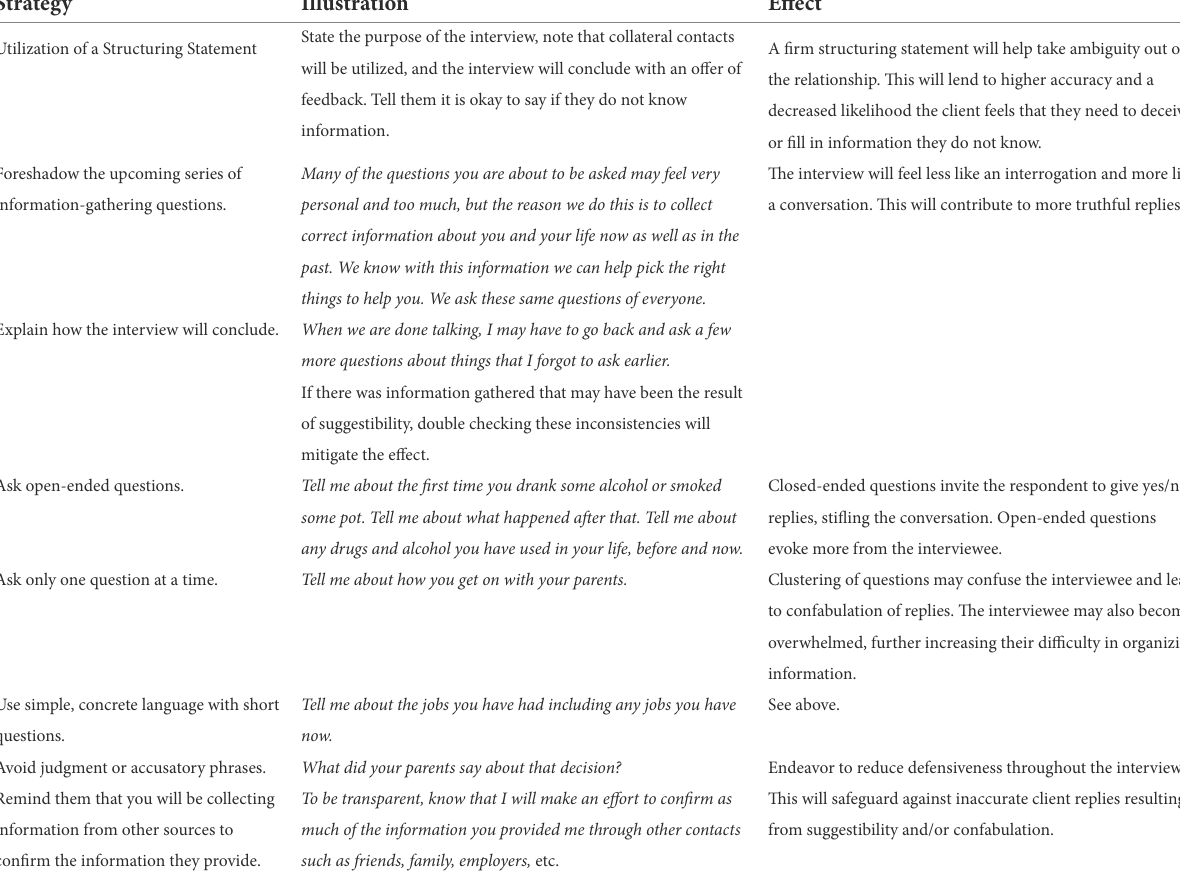
TABLE 2 Strategies to address the potential presence of confabulation and